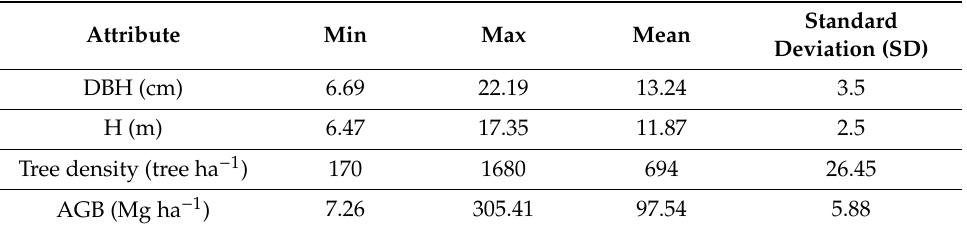
Table 5. Characteristics of the mangrove trees in